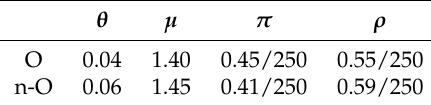
Table 3. Policy parameter calibration.